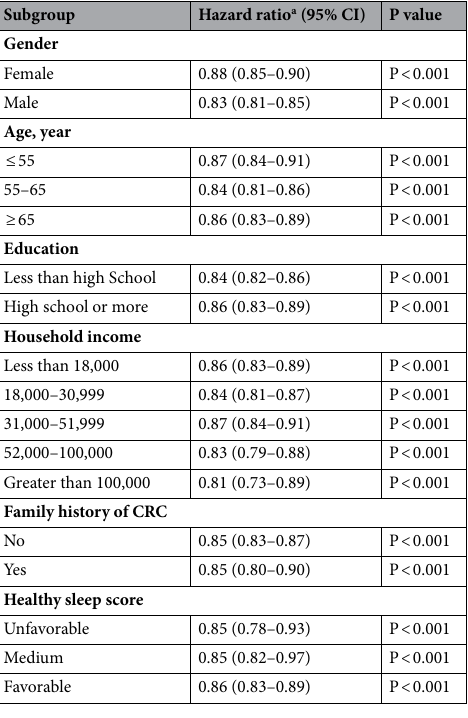
Table 4. Hazard ratio (95% CI) of CRC events per 1-number increment in Healthy Lifestyle Score among participants. a Hazard ratios (95% CI) were adjusted for age, sex, education, household income, family history of CRC, healthy sleep score.